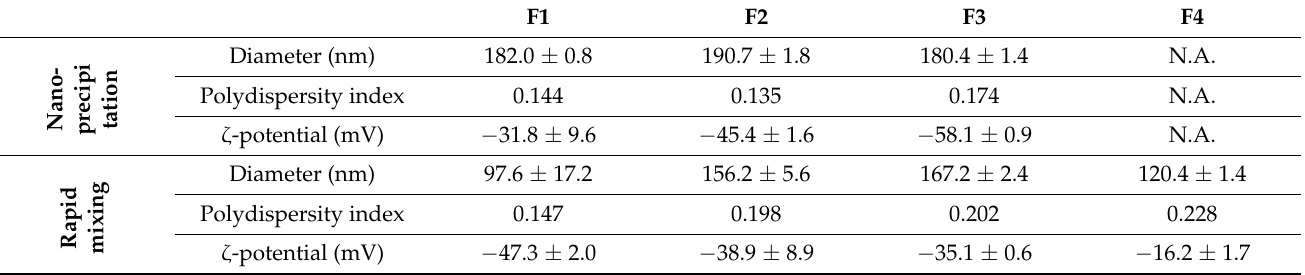
Table 1. Physicochemical properties of GLN nanoformulation function of the formulation process. F1 F2